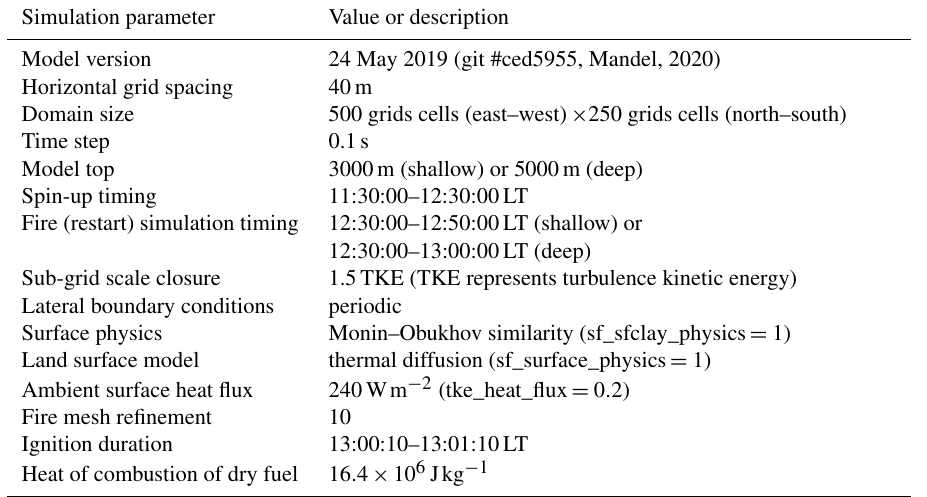
Table 1. Key parameters of numerical domain setup.